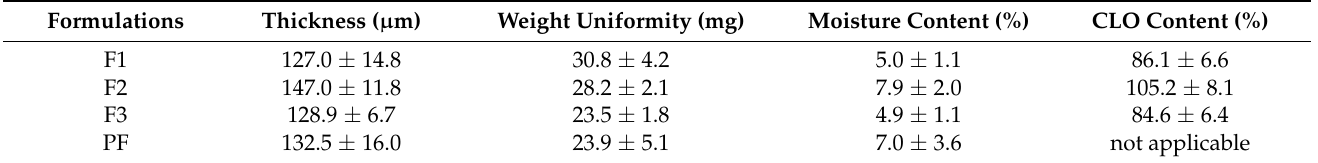
Table 2. Films characteristics: thickness, weight, moisture, and drug content (mean ± SD, n = 3). Formulations Thickness ( µ m) Weight Uniformity (mg) Moisture Content (%) CLO Content